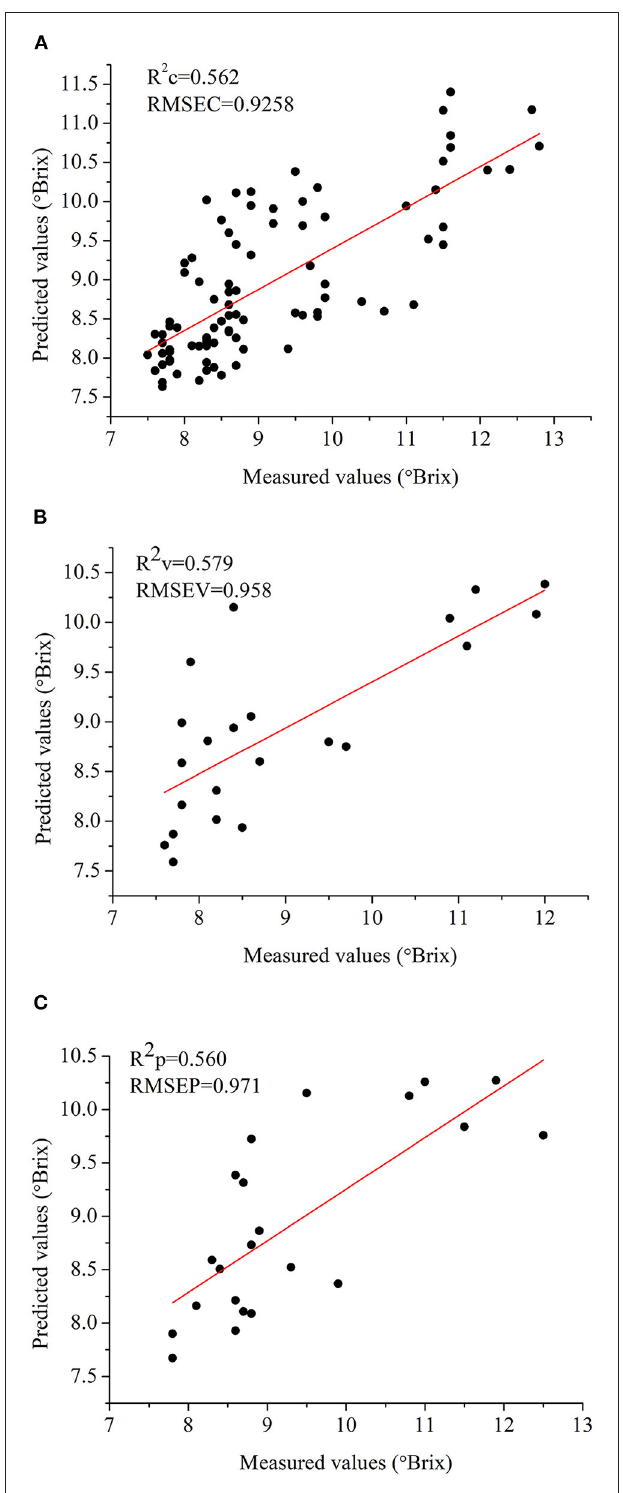
FIGURE 8 | Prediction results of SSC using 1D ResNet. (A) Results of the training set, (B) results of the validation set, (C) results of the testing set. R 2 c, R 2 v, and R 2 p mean the R 2 of training, validation, and testing, respectively. RMSEC, RMSEV, and RMSEP mean the root mean square error (RMSE) of training, validation and testing,